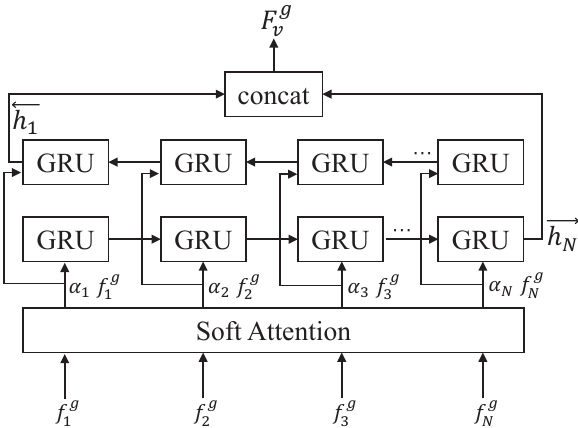
Figure 5. Video global semantic encoding